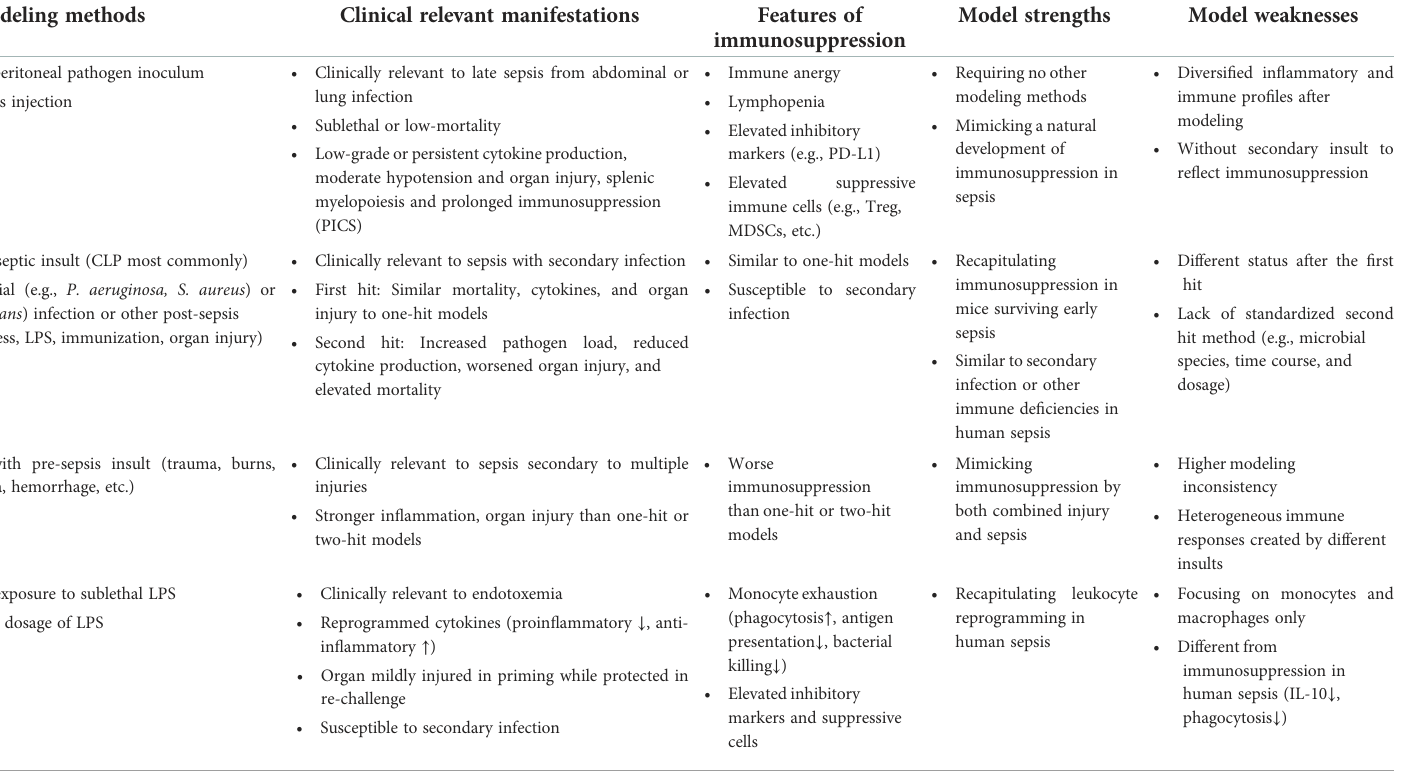
TABLE 1 Comparison of major modeling methodologies used to generate murine models of sepsis-associated